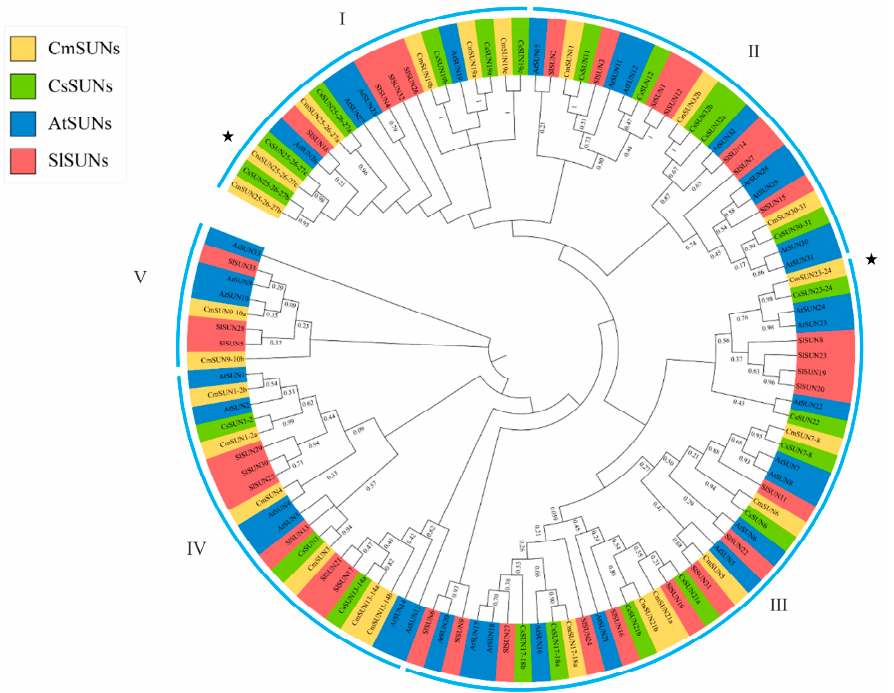
Figure 4. Phylogenetic tree analyses of SUN proteins from Arabidopsis , Solanum Lycopersicon , Cucumis sativus , and Cucumis melo . The blue represents AtSUNs, the green represents CsSUNs, the yellow represents CmSUNs, and the red represents SlSUNs. ‘ Ⅰ~Ⅴ ’ indicates different subfamily of SUN members in four species. The asteriskindicates the functionally studied CmSUN genes.